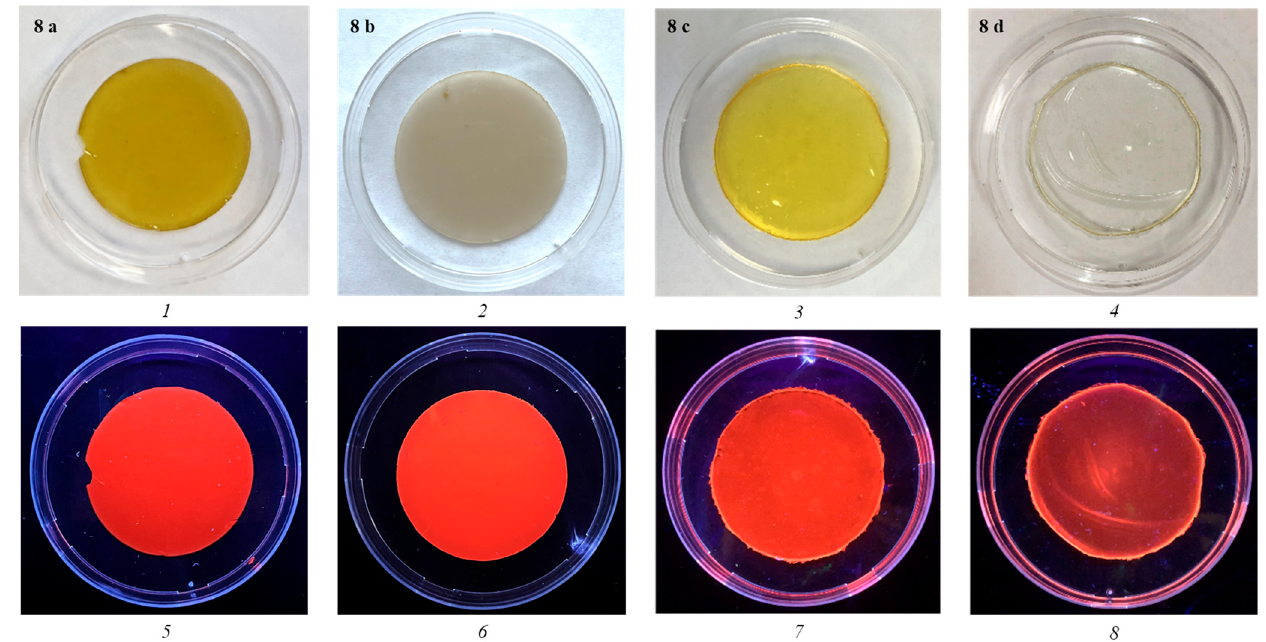
Figure 6. Photographs of cross-linked luminescent polymers 8 a – d in daylight ( 1–4 ) and under excitation with light at 365 nm ( 5 – 8 ). Table 1. Physicochemical properties of cross-linked polymers and precursors.